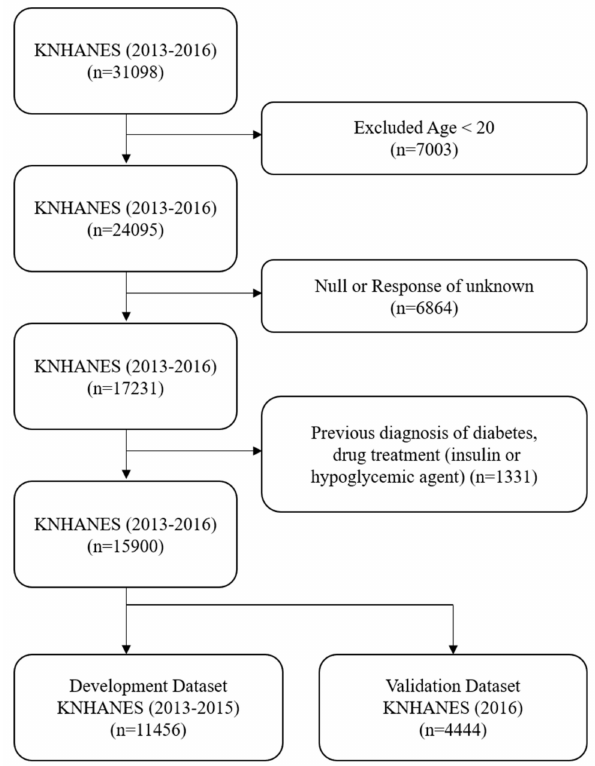
Figure 2. Flow chart for selecting the study